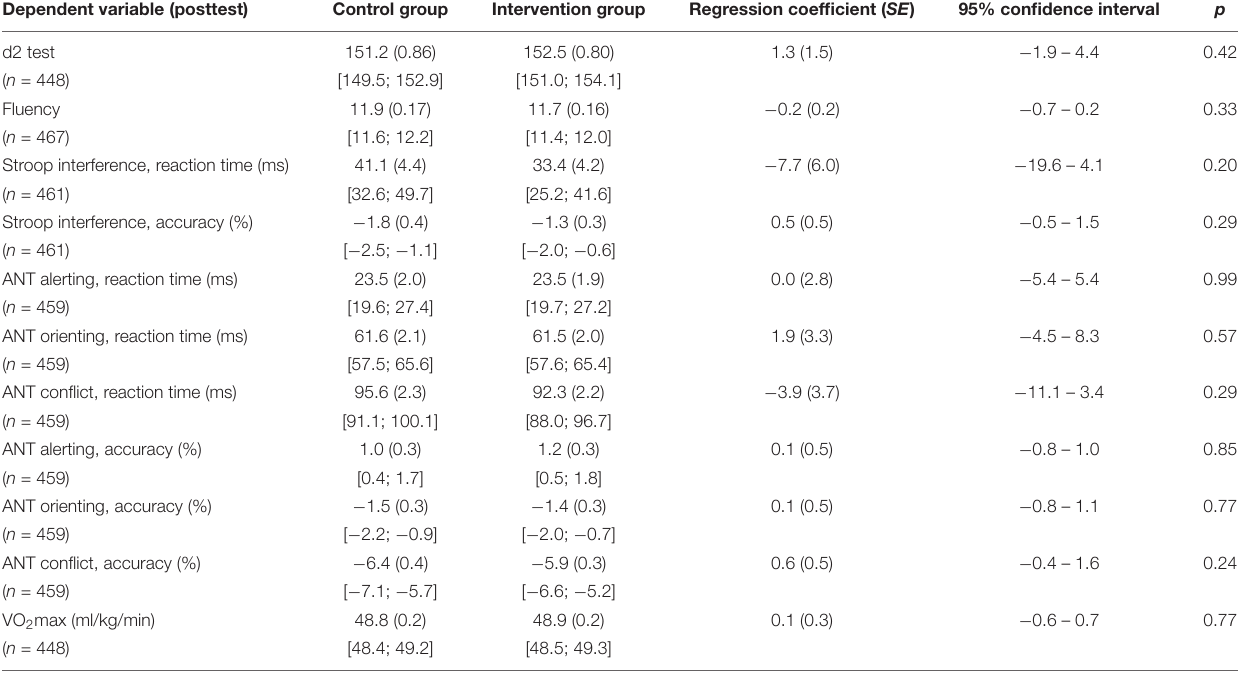
TABLE 2 | Test performance (means, standard errors, and [95% confidence intervals]) and statistics of the mixed model analyses for cognitive performance and fitness. Dependent variable (posttest)